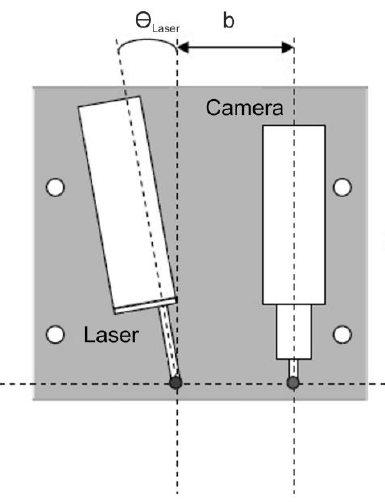
Figure 5. Orientation of the camera and laser on the aluminum mount. The distance b between the laser and camera is 105.1 mm and the angle (θ Laser ) is 2.0°.